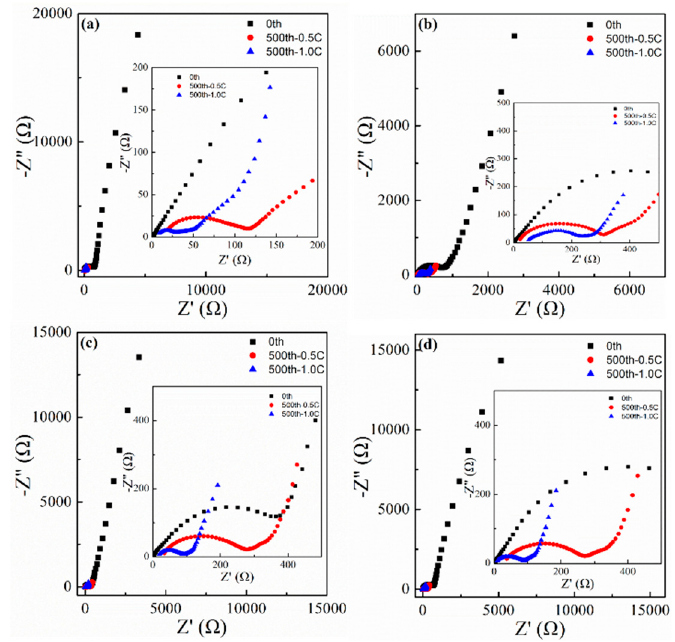
Figure 10. Electrochemical impedance spectra (EIS) spectra for the cells employing ( a ) Co 3 O 4 -Cl, ( b ) Co 3 O 4 -SO 4 , ( c ) Co 3 O 4 -AC, and ( d ) Co 3 O 4 -NO 3 before and after cycling.